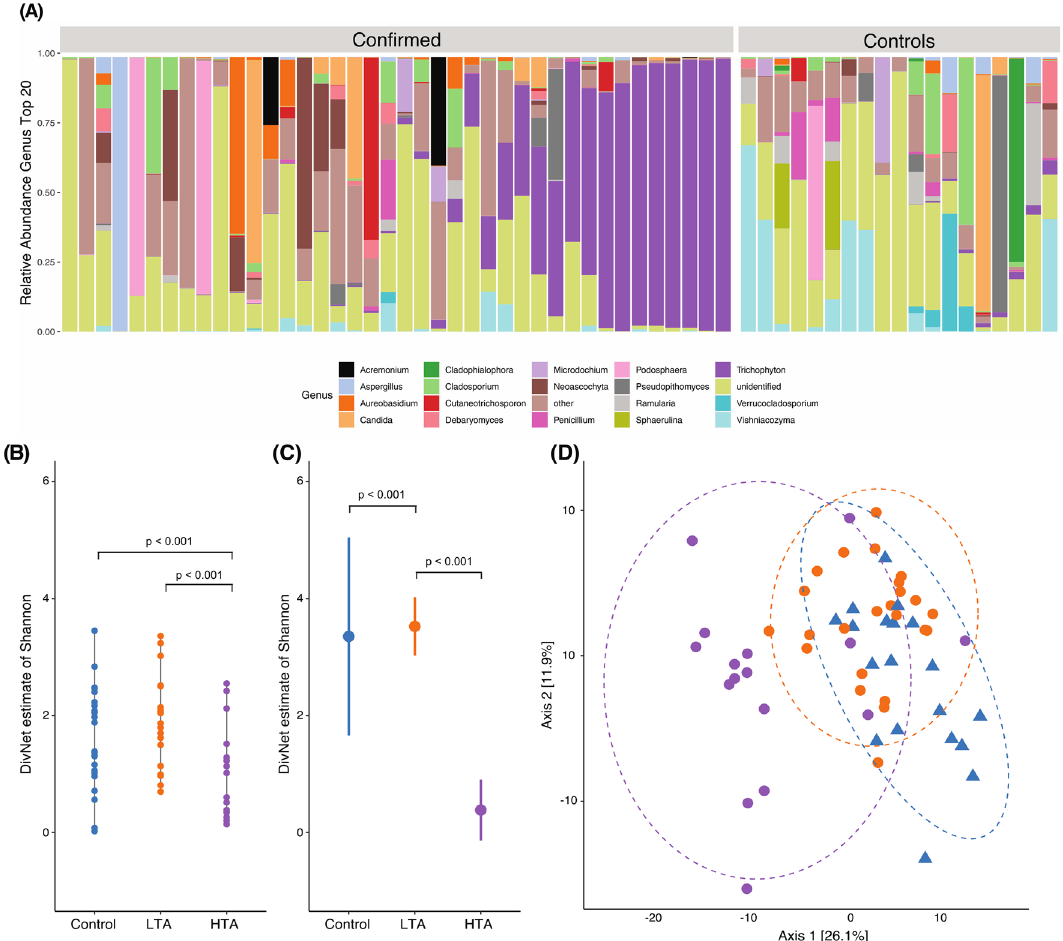
Figure 2. Composition of toenail fungal communities. ( A ) The 20 most abundant fungal genera (average across samples) were selected for visualization The category others comprises all remaining genera Samples are depicted in cohort grouping of confirmed case- and healthy control samples Within those groups the samples were arranged based on the abundance of genus Trichophyton in order to visualize the found subdivision in the case group. ( B ) Alpha diversity in sample-wise estimates showed no difference between controls and LTA group Compared to the control group a significant decrease in Shannon diversity was observed ( p < 0.001, decrease 0.8934, s.e. 0.1886) in HTA samples. ( C ) Estimated alpha diversity in community-wise comparison using Shannon The low Trichophyton abundance (LTA) group showed a significant increase in diversity compared to the healthy controls ( p = 0.001, increase 0.1719, s.e. 0.0511) The high Trichophyton abundance (HTA) group had a significantly lower diversity compare to the control group ( p < 0.001, increase 2.9728, s.e. 0.0652). ( D ) Principle coordinate analysis (PCoA) of case/control samples based on the Euclidian distance on PhILR transformed counts with blue triangles referring to controls, orange circles to LTA cases and violet circles to HTA cases Axis 1 capture 26.1% of the variation and separates the cases into two distinct